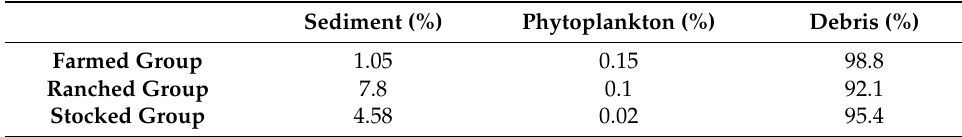
Table 5. Food composition of three groups.